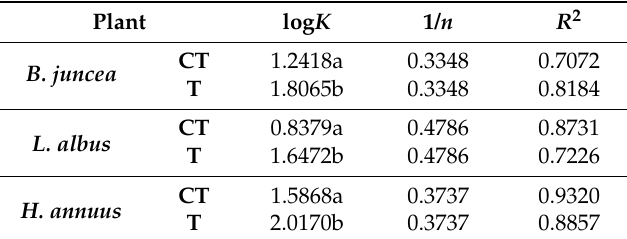
Table 4. Relationship between shoot uptake and potentially available concentration of As in soil. Parameters of the Freundlich-like model by setting 1/ n as shared parameter.